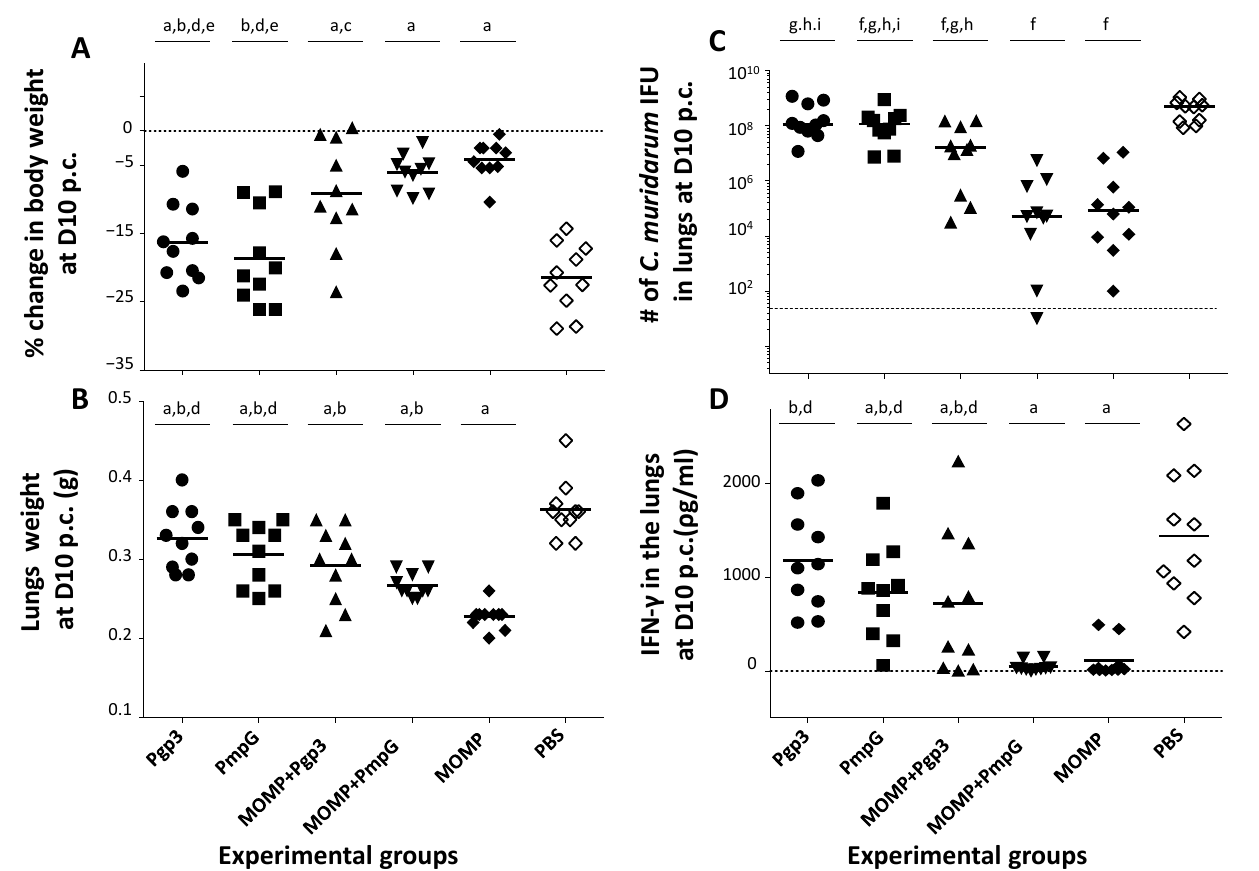
Figure 9. Systemic and local disease burden and local immune responses in the lungs in vaccinated mice following the i.n. challenge with C. muridarum . ( A ) Percentage change in mean body weight at D10 following the i.n. challenge. The mean is shown as a horizontal line. Each symbol repre- sents a single animal. a p < 0.05 by the Student’s t -test compared with the PBS immunized group. b p < 0.05 by the Student’s t -test compared with the MOMP immunized group. c p < 0.1 by the Student’s t -test compared with the MOMP immunized group. d p < 0.05 by the Student’s t -test compared with the MOMP+PmpG immunized group. e p < 0.05 by the Student’s t -test compared with the MOMP+Pgp3 immunized group. ( B ) Lungs weight (g) at D10 after the i.n. challenge. The mean is shown as a horizontal line. Each symbol represents a single animal. a p < 0.05 by the Student’s t -test compared with the PBS immunized group. b p < 0.05 by the Student’s t -test compared with the MOMP immunized group. d p < 0.05 by the Student’s t -test compared with the MOMP+PmpG immunized group. ( C ) Number of C. muridarum IFU recovered from the lungs at single animal. f p < 0.05 by the Mann–Whitney’s U -test compared with the PBS immunized